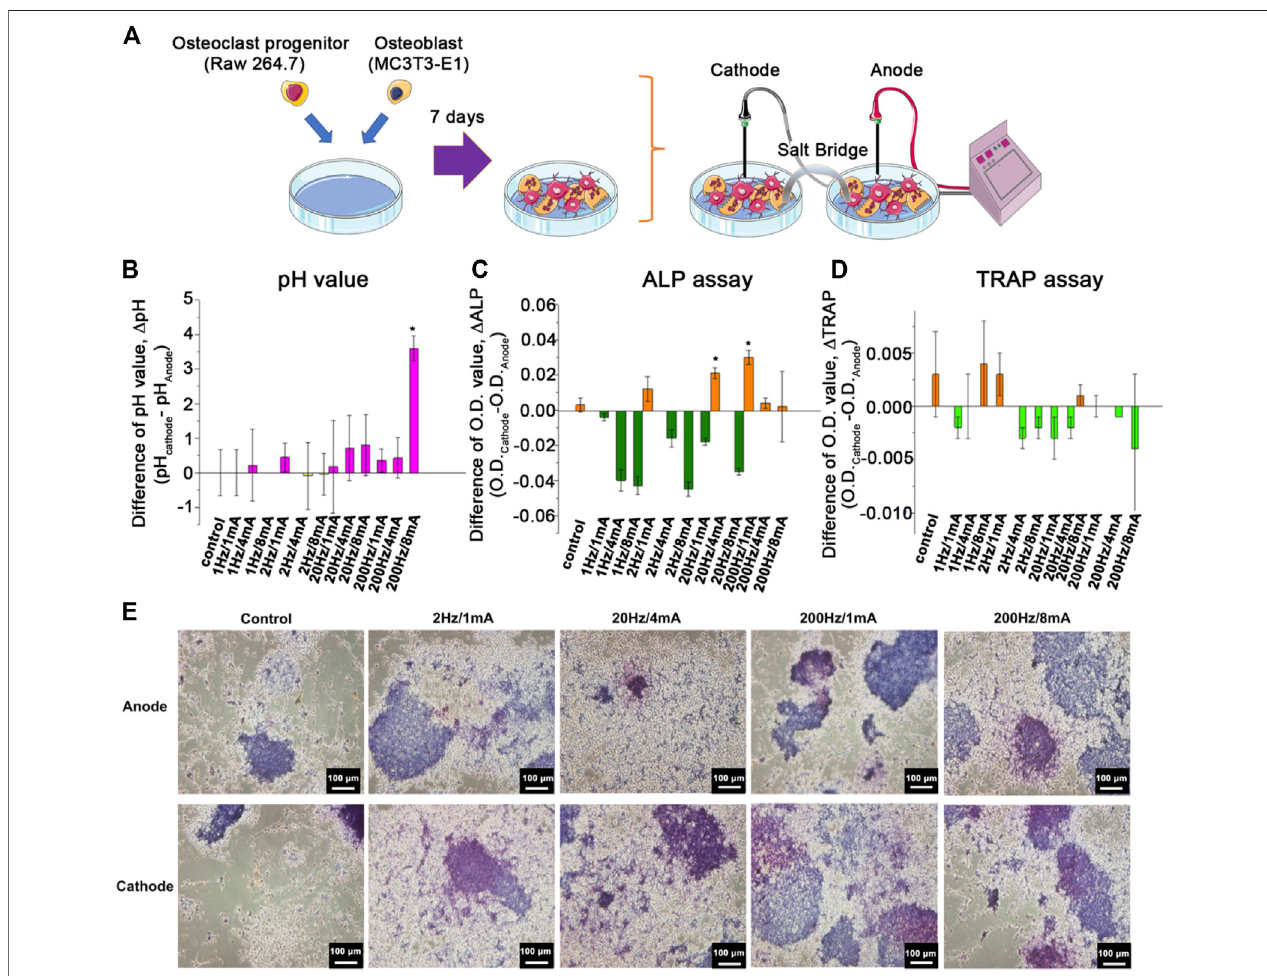
FIGURE 1 | (A) Schematic fi gure of an in vitro OB/OC co-culture system treated with ES. The difference of (B) the pH value ( Δ pH) of the medium, (C) ALP expression ( Δ ALP), and (D) TRAP expression ( Δ TRAP) of the co-cultured cells at the cathode and anode site after treating ES with 1 Hz/1 mA, 1 Hz/4 mA, 1 Hz/8 mA, 2 Hz/1 mA, 2 Hz/4 mA, 2 Hz/8 mA, 20 Hz/1 mA, 20 Hz/4 mA, 20 Hz/8 mA, 200 Hz/1 mA, 200 Hz/4 mA, and 200 Hz/8 mA. (E) The histological analysis of the ALP expression of the co-cultured cells at the cathode and anode site without ES and after treating ES with 2 Hz/1 mA, 2 Hz/4 mA, 20 Hz/4 mA, 200 Hz/1 mA, and 200 Hz/8 mA. The control group indicated the cells treated with ES treatment on the culture dish without the GGT scaffold. ( n = 6, * p <